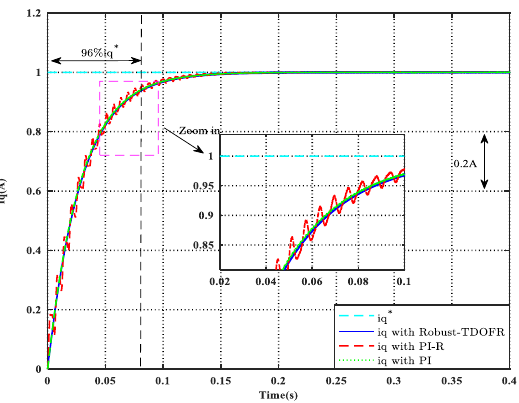
Figure 8. Step response comparison results of Robust-TDOFR and PIR.